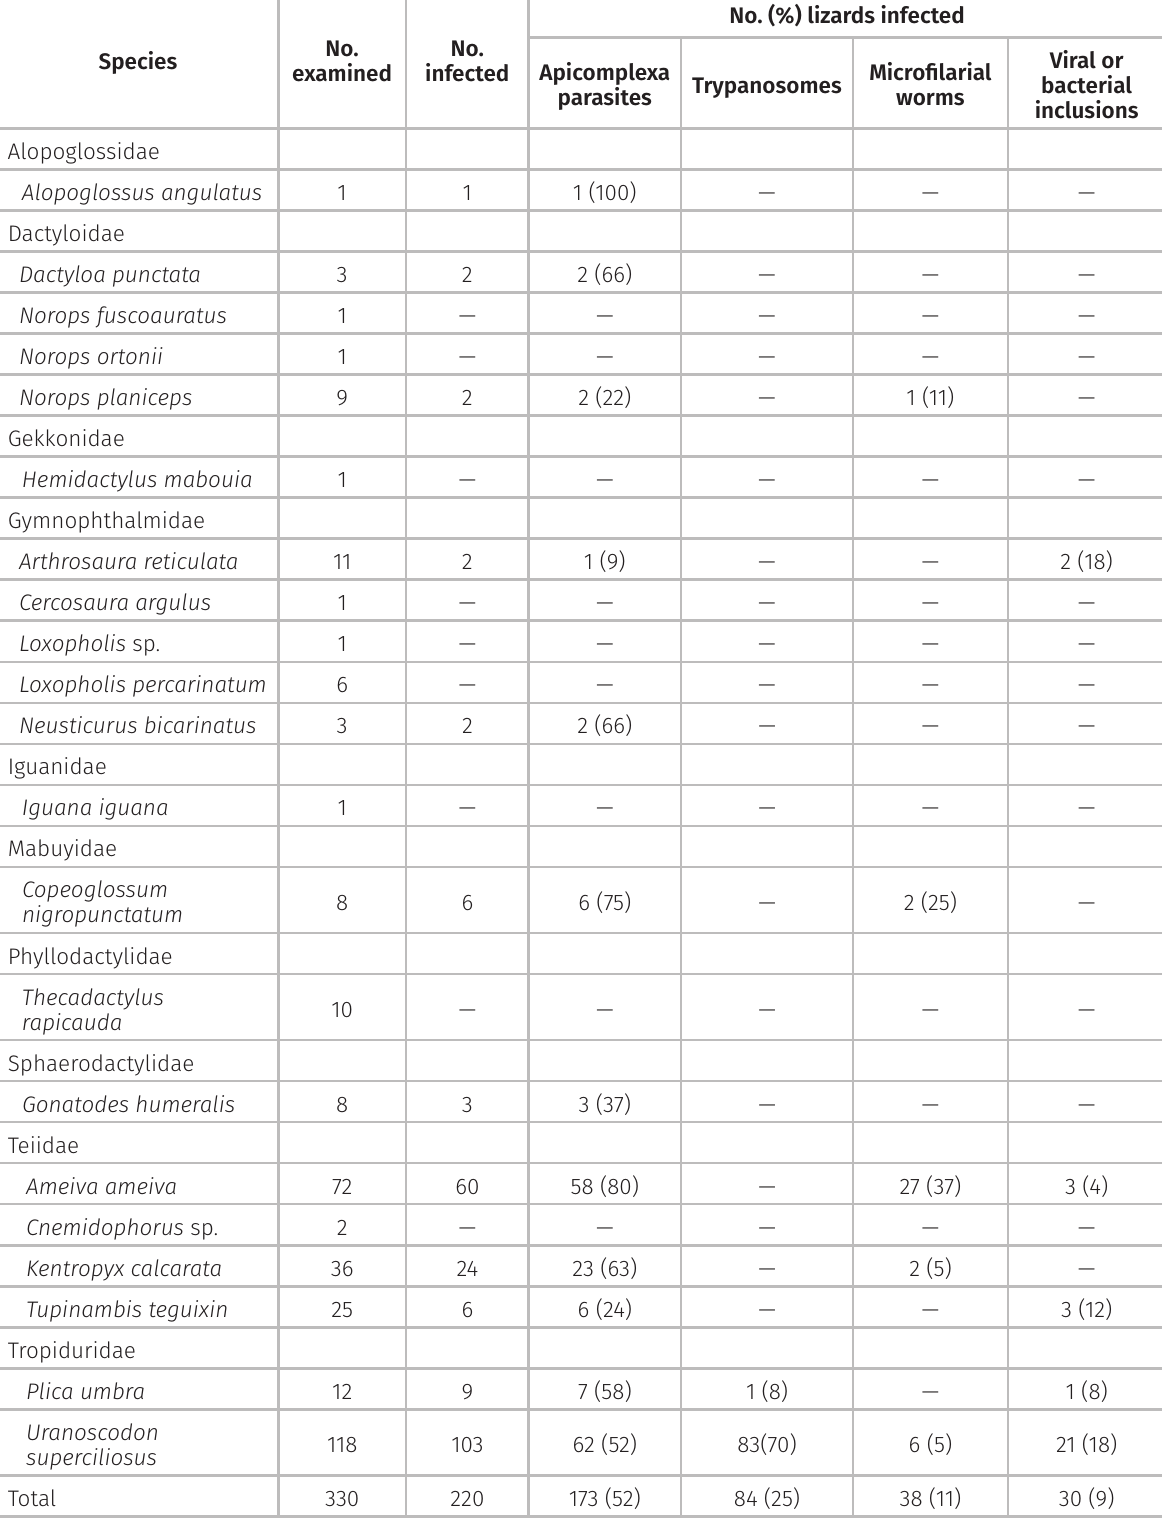
Table II. Prevalence of haemoparasites in lizards from Central Amazonia. Species